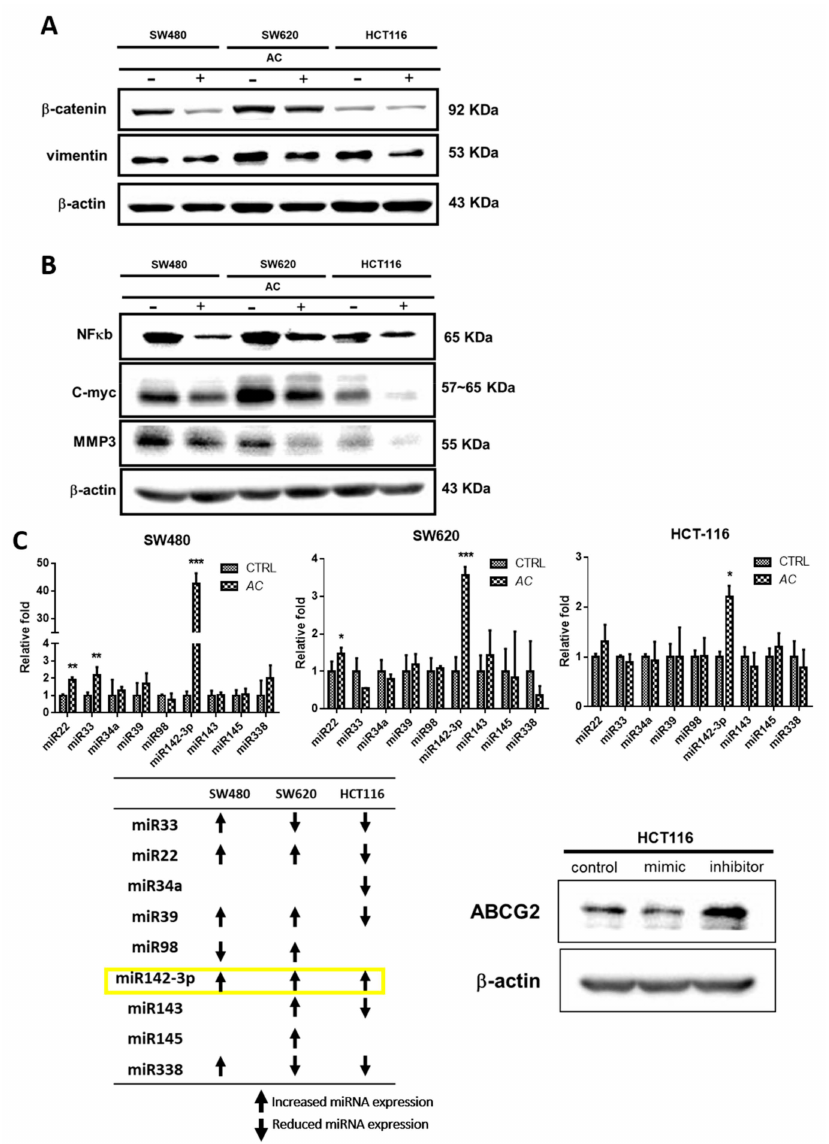
Figure 4. Impact of AC on the signaling pathway of CRC cell lines. AC (100 µ g / mL) treatment were given to CRC cells for 24 h. ( A ) AC significantly decreases the EMT associated β -catenin and vimentin gene expression, ( B ) suppression of oncogenic markers NF- κ b, C-myc and MMP3, and ( C ) upregulation of miRNA expression, specially miR142-3p, and miR142-3p expression negatively regulates ABCG2. * p < 0.05, ** p < 0.01 and *** p <